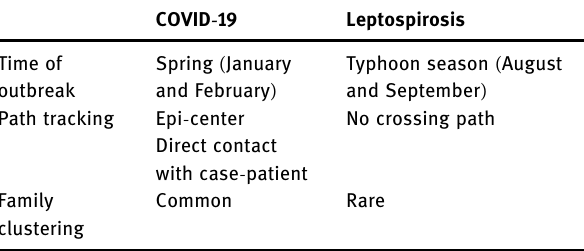
Table 1: Epidemiological investigation COVID - 19